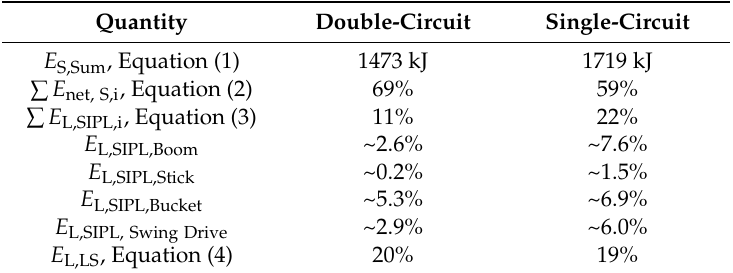
Table 2. Energy Analysis of 90 Degree Digging Cycle according to Energy Formulas (1)–(4). Quantity